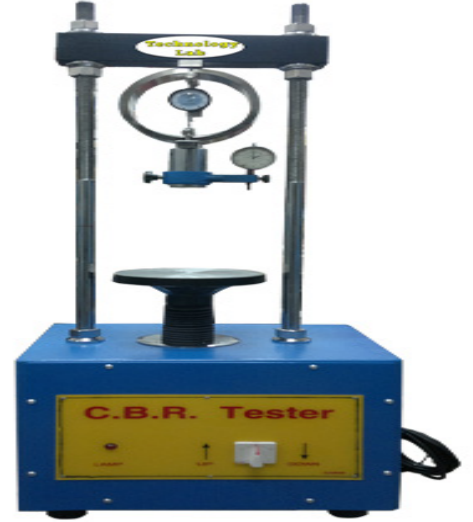
Figure 4. Determination of CBR with a CBR apparatus.